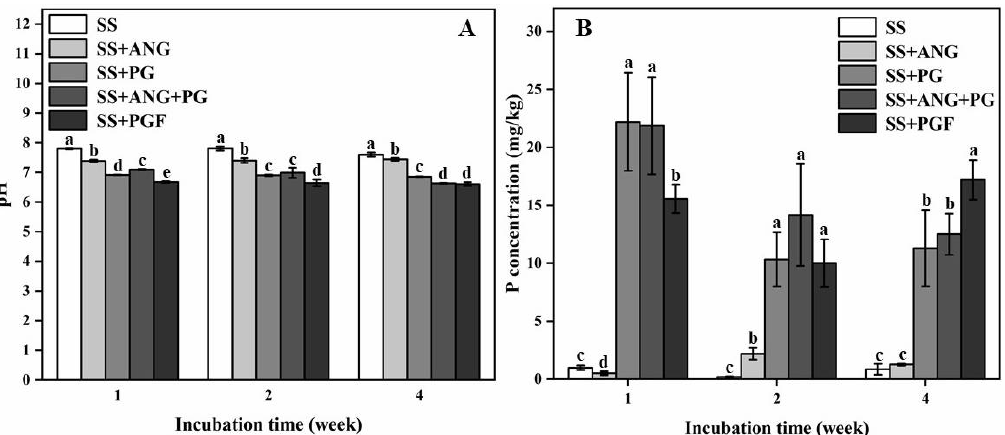
Figure 5. The pH value ( A ) and soluble P concentration ( B ) in soil between SS, SS + ANG, SS + PG, SS + ANG + PG, and SS + PGF treatments during incubation (1, 2, 4 weeks). PGF, PG fertilizer. The different lower-case letters indicate a significant difference between the treatments ( p < 0.05). The significant differences among the treatments were identified by the Tukey test ( p < 0.05).